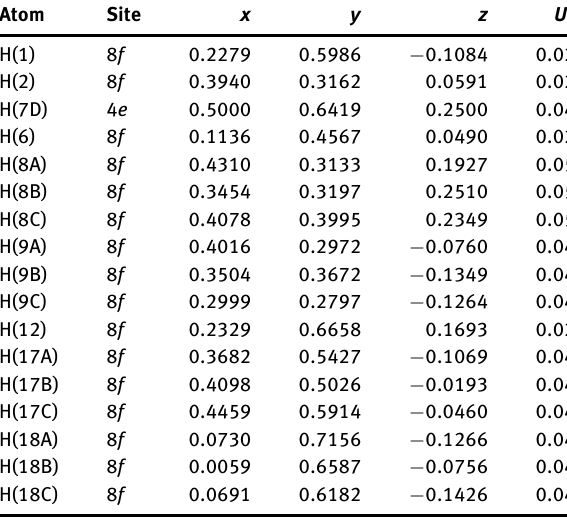
Table 2: Fractional atomic coordinates and isotropic or equivalent isotropic displacement parameters (Å 2